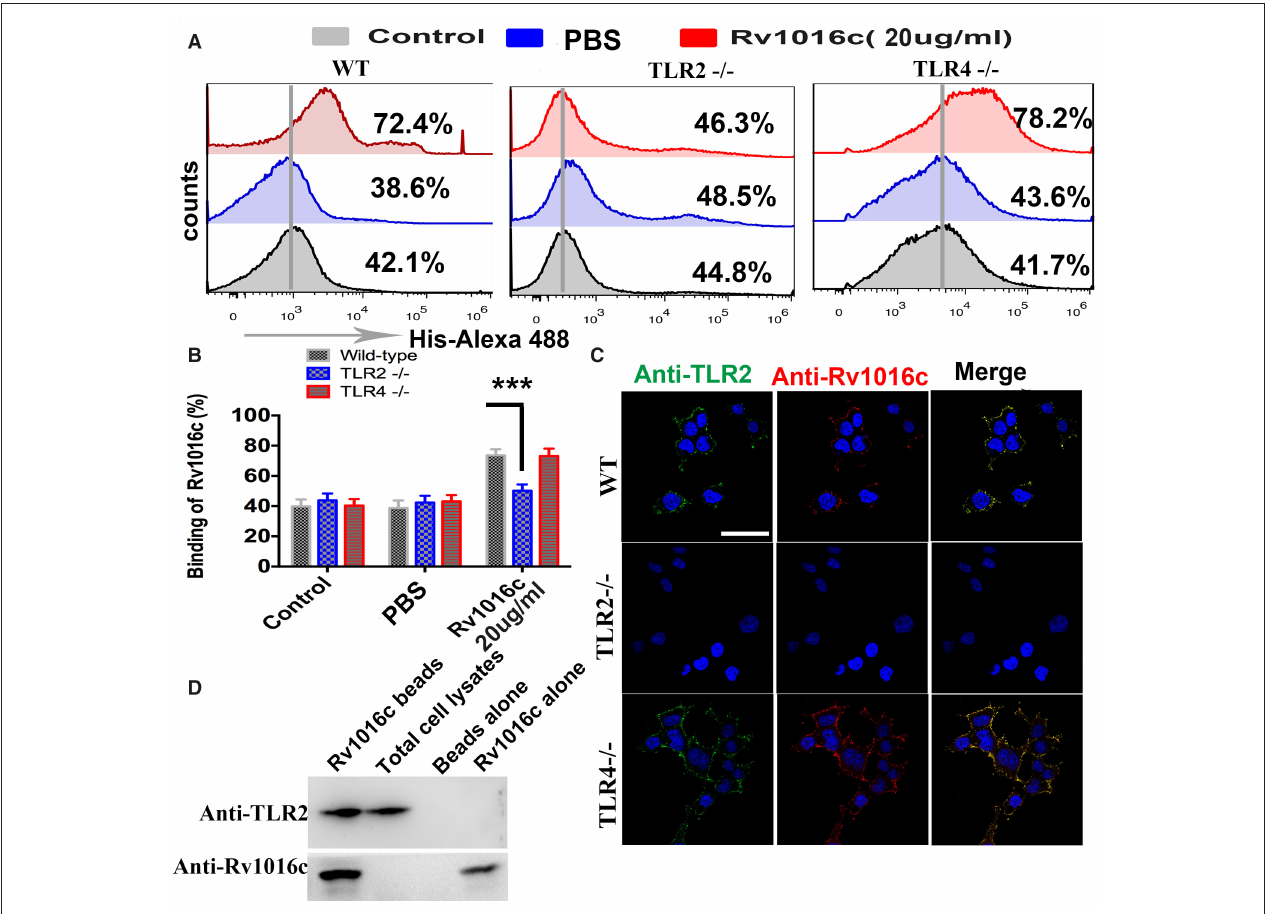
FIGURE 3 | Rv1016c interacts with TLR2, but not with TLR4. (A,B) Macrophages derived from WT, TLR2 − / − , and TLR4 − / − mice were incubated with Rv1016c-His (20 µ g/ml) for 1 h, followed by incubation with Alexa488-conjugated anti-His Abs. After washing and staining, flow cytometry was used to examine the binding between Rv1016c and TLR2. (C) Macrophages derived from WT, TLR2 − / − , and TLR4 − / − mice were treated with Rv1016c (20 µ g/ml) for 1 h, fixed and stained with primary antibodies (mouse anti-Rv1016c, rat anti-mouse TLR2), followed by incubation with appropriate Alexa488- or Alexa555-conjugated secondary antibodies. Cells were photographed under fluorescence microscopy (original magnification × 63). Scale bar = 10 µ m (D) Cells were incubated with Rv1016c immobilized on Ni-NTA beads for 6 h, and proteins were visualized by Western blotting with anti-His or anti-TLR2 Abs to assay the presence of TLR2 with bead bound proteins. All data were generated from three independent experiments and Data are shown as Means ± SD of triplicate wells. (*** p < 0.001, determined by Student’s t